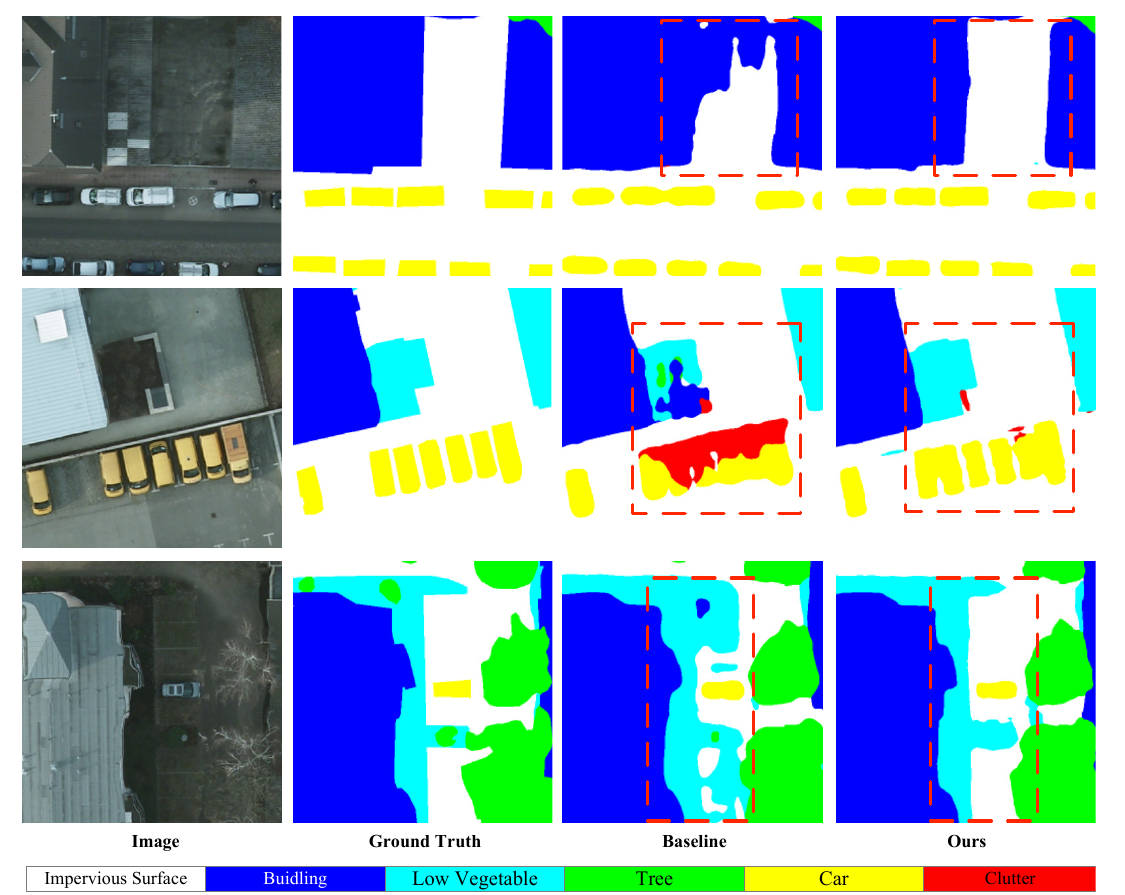
Figure 8. Qualitative comparisons against the Baseline on the Potsdam test set. We marked the improved regions with red dashed boxes (best viewed when colored and zoomed in). Table 7. Quantitative comparisons with state-of-the-arts on Vaihingen test